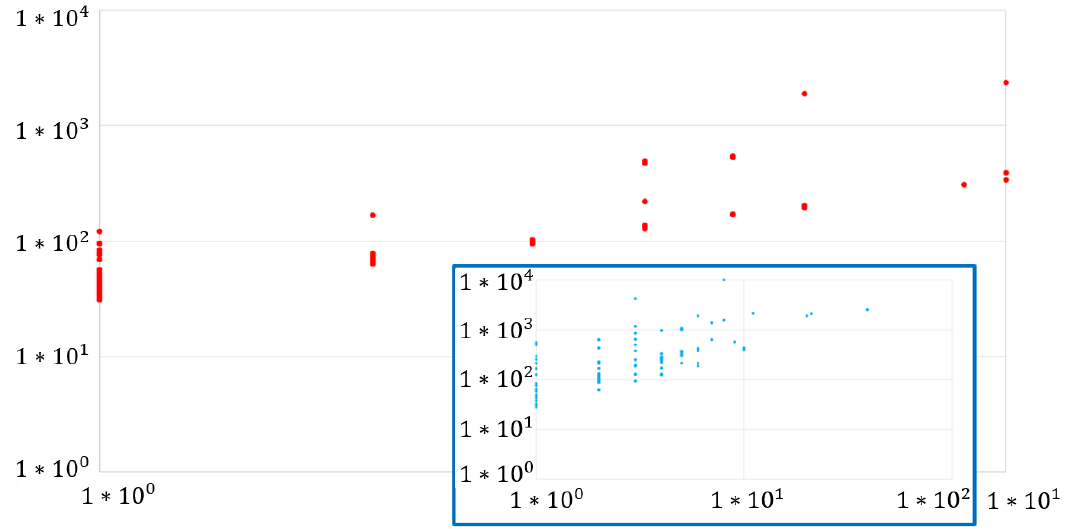
Figure 8. Downlink (red) and uplink (blue) traffic flow distribution of APN “A2” (x axis: number of packets, y axis: Size of flows